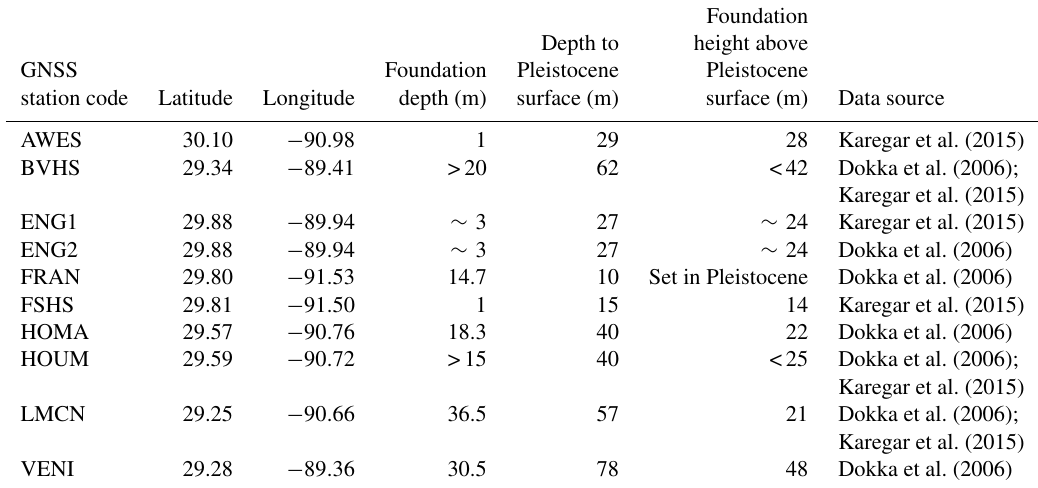
Foundation Depth to height above